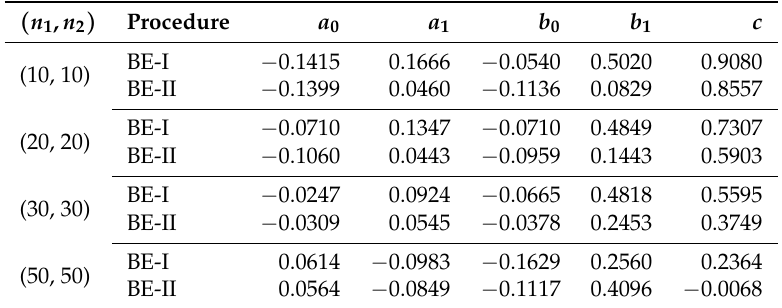
Table 1. The relative bias (RB) of Bayes estimates for n 1 = n 2 = 10, 20, 30, and